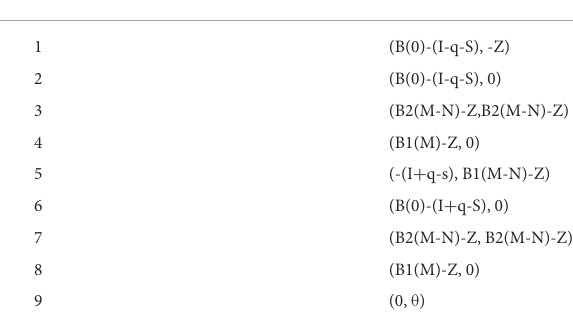
TABLE 1 Participant’s return function. Number Revenue